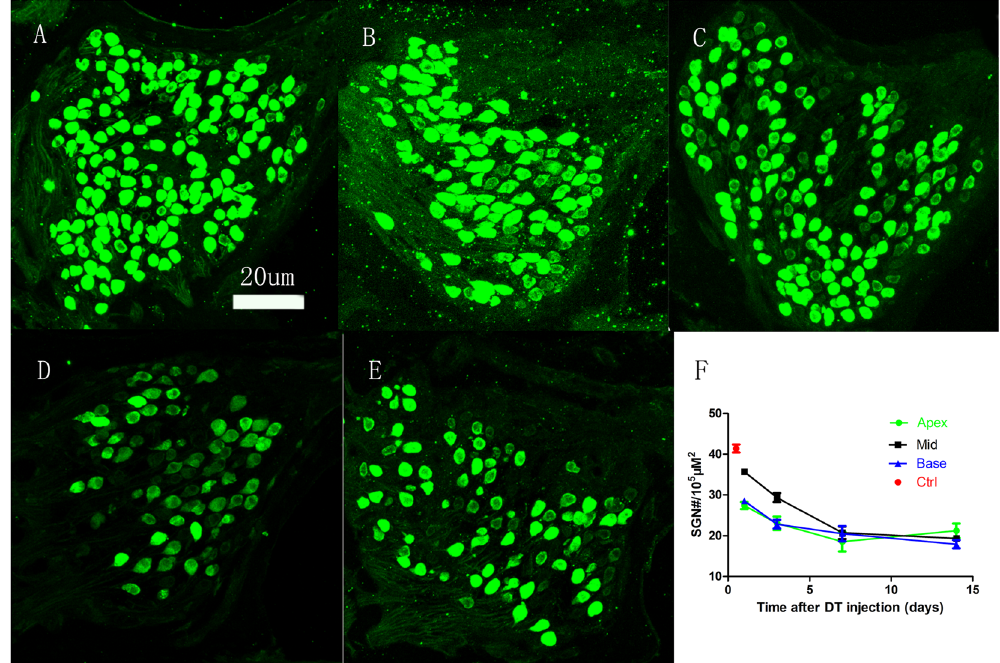
Figure 5. DT-induced changes in SGN density. Representative images of SGNs in Rosenthal’s canal at the basal turn acquired from control subjects and Cre + subjects measured at 1, 3, 7, and 14 days after the DT injection ( A – E , respectively). Quantitative changes of SGN density at the three locations (apex, middle, and basal) as a function of time after the DT injection ( F ).